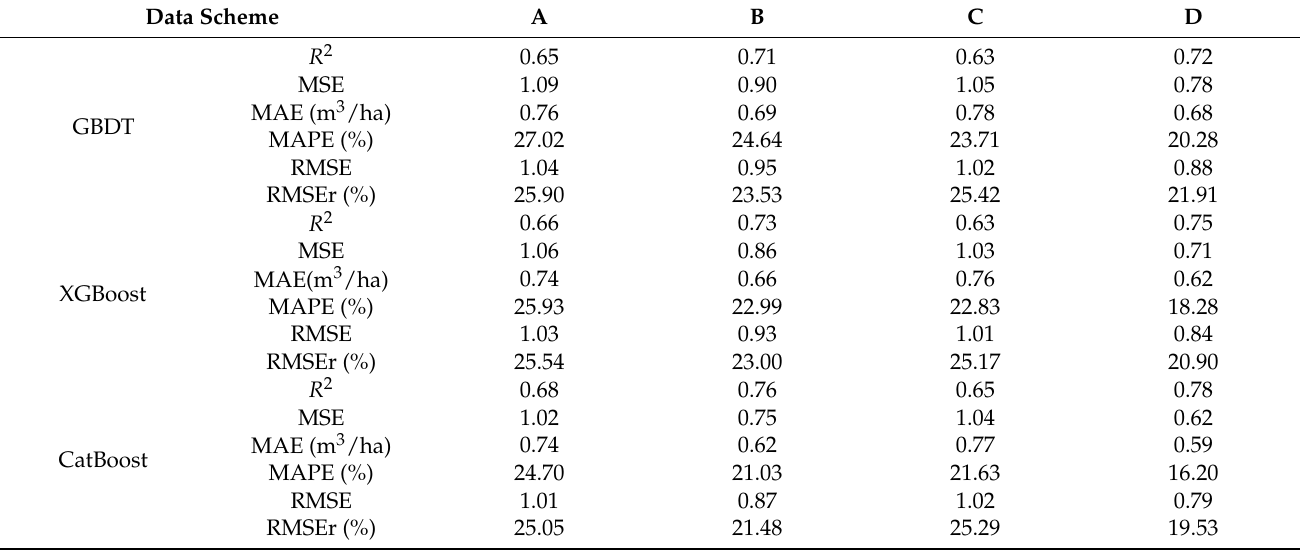
Table 5. Performance indicators for forest growing stock estimation based on data schemes A, B, C, and